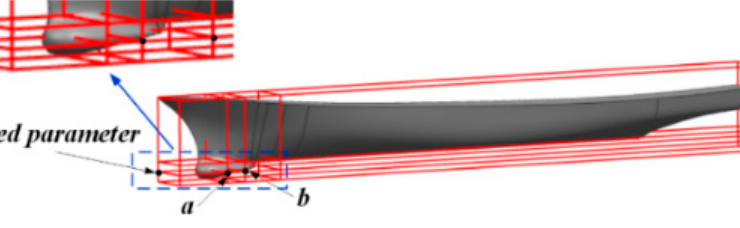
Figure 1. Design variables distribution for changing the original ship model.